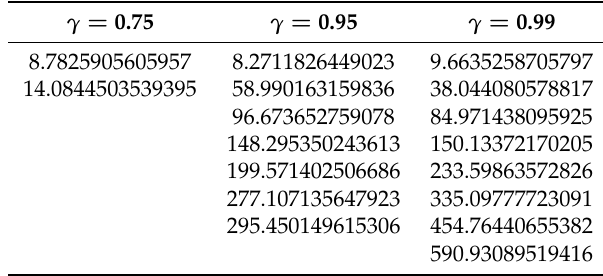
Table 1. Eigenvalues for different values of γ .